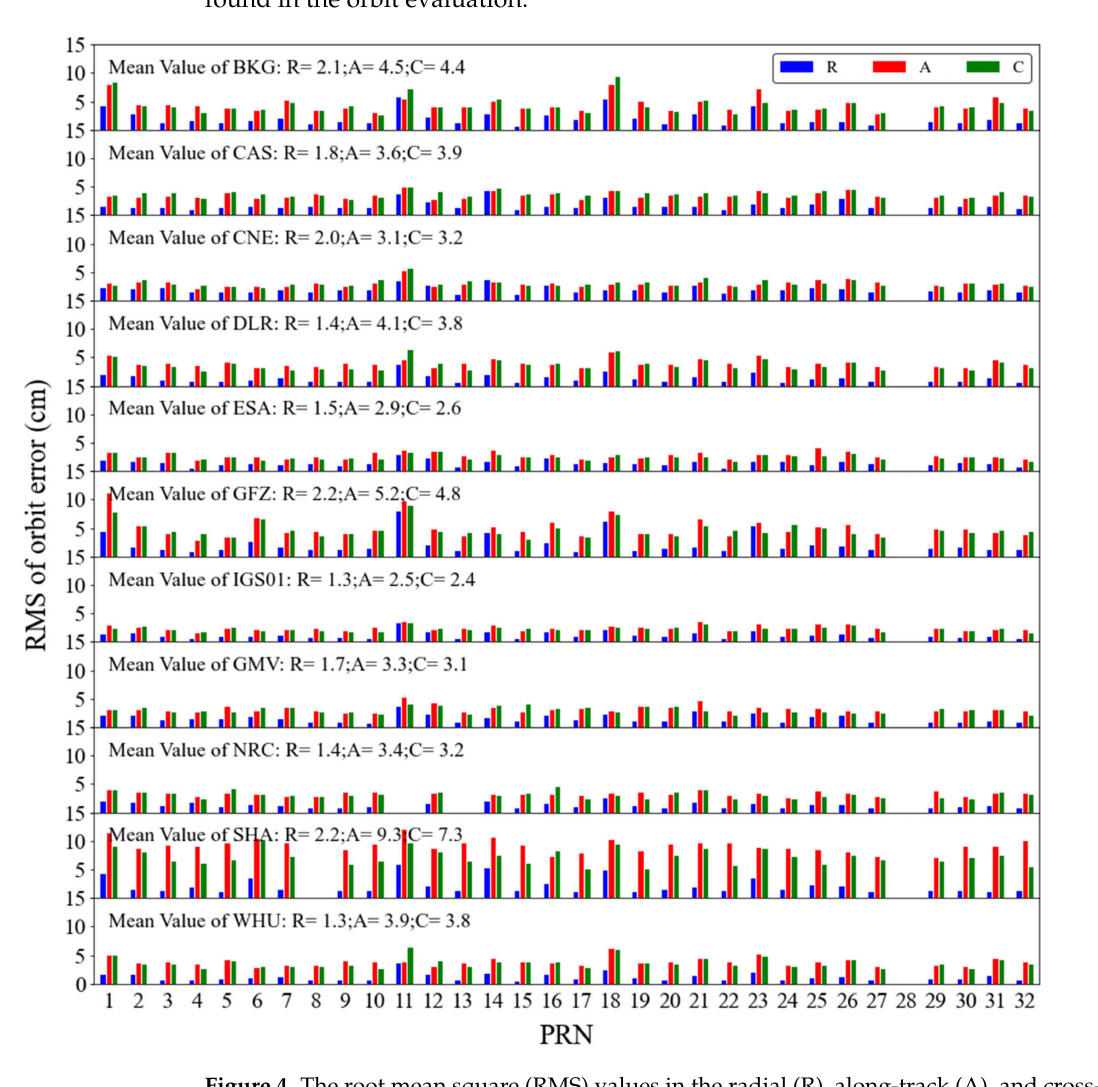
Figure 4. The root mean square (RMS) values in the radial (R), along-track (A), and cross-track (C) directions of GPS real-time orbits from different IGS ACs (the mean RMS of orbit errors for all GPS satellites is shown in each